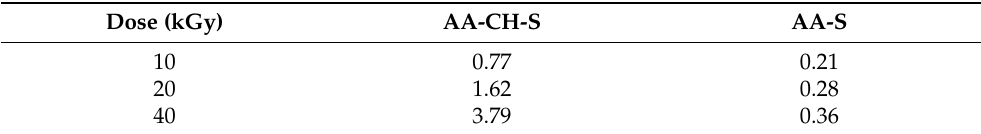
Table 5. The average total color difference ( ∆ E ) results for the analyzed films. Dose